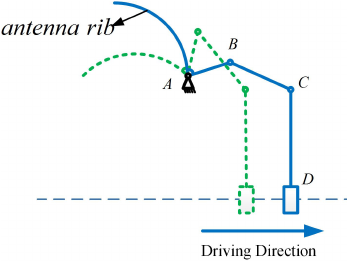
Figure 11. Penetration in clearance joint.